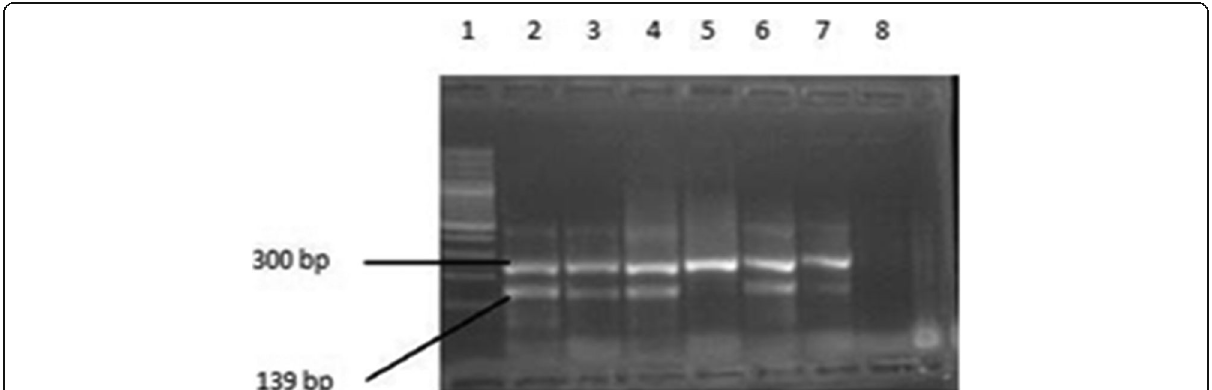
Fig. 1 Showing plasminogen activator inhibitor-1 (4G/5G) polymorphism genotyping, lane 1: marker-ladder 100 bp (ferments), all lanes next to lane 1: showed bands at 300 bp (representing amplification of the control primer), after lane 1: each two subsequent lanes represent insertion (4G) then deletion (5G) polymorphism genotyping for every case, lanes 2, 3 (case 1) and 6, 7 (case 3): show bands at 139 bp representing both 4G and 5G heterozygous genotype, lanes 4, 5 (case 2): show a 139 bp band only at lane 4 representing 4G genotype